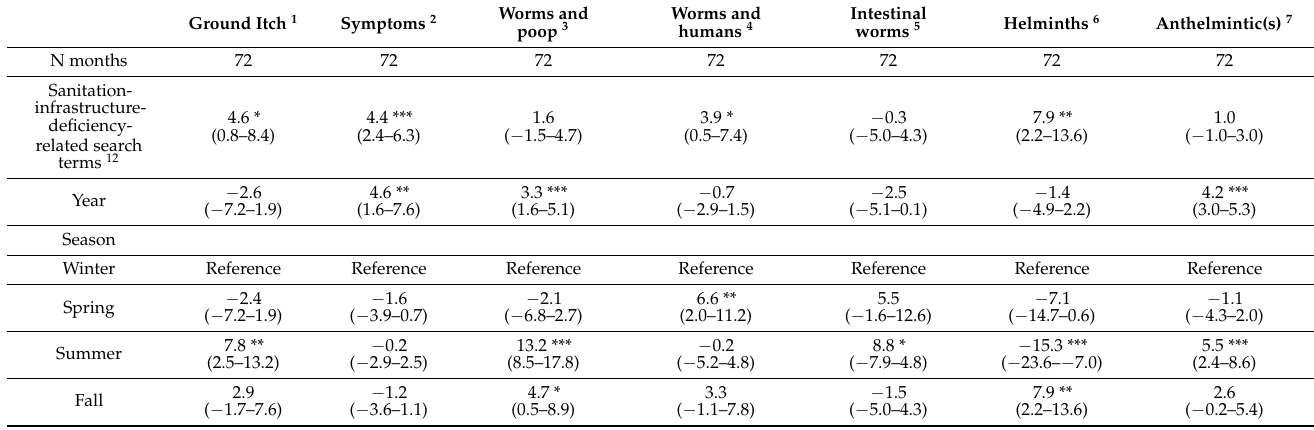
Table 4. Regression coefficients (95% confidence intervals) of relative search traffic across fourteen different categories of search terms from a national time series of Google search terms. The superscript number for each outcome corresponds to Table 1 showing the exact search terms